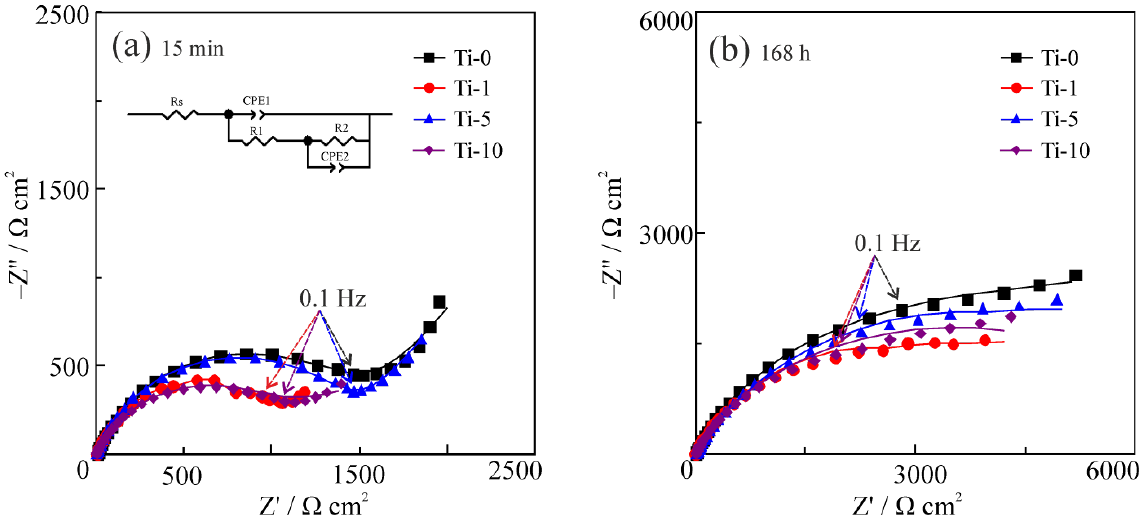
Figure 11. Nyquist EIS plots of Cu – Sn and Cu – Sn – TiO 2 coatings after 15 min ( a ) and 168 h ( b ) of exposure to 3% NaCl solution. Symbols correspond to experimental data and lines are results of curve fitting. Equivalent circuit used for data evaluation is shown as an inset in ( a ).